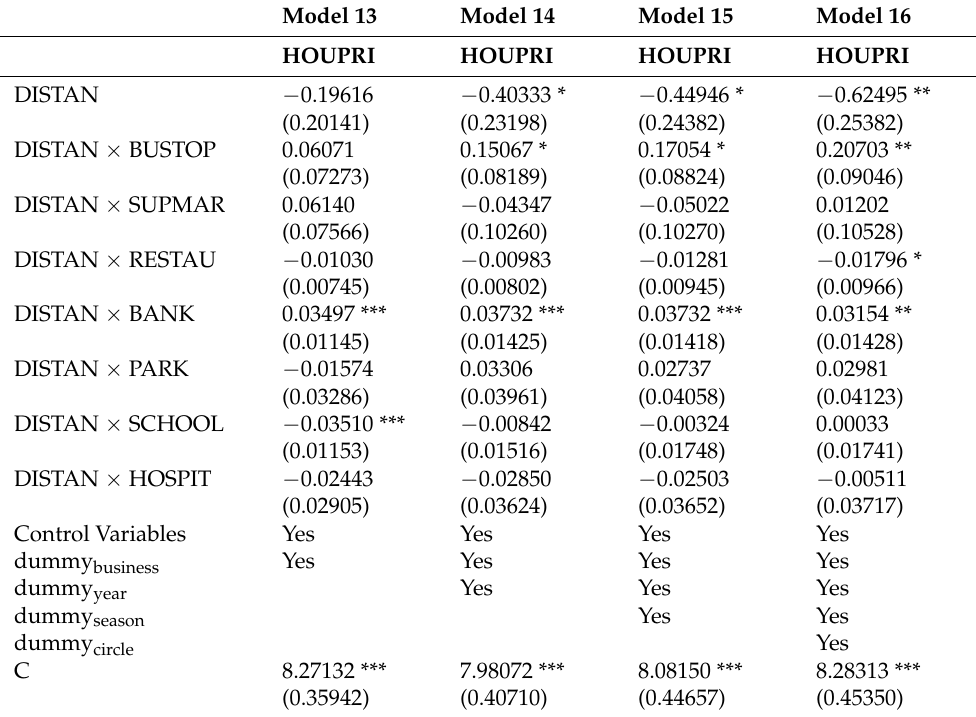
Table 5. The moderating roles of accessibilities after the release of the assessment